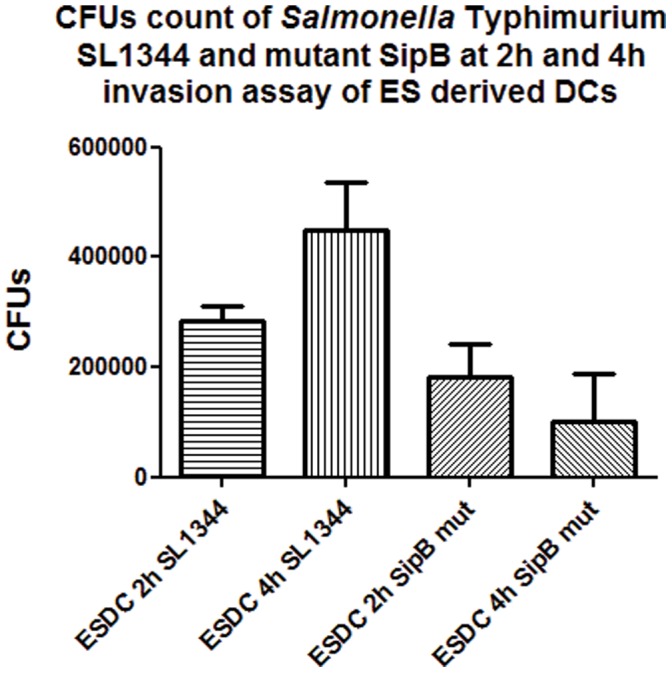
Gentamicin invasion assay.The ability of S. Typhimurium SL1344(p1C/1) to invade ESDCs was measured by the gentamicin assay described in Methods. ESDCs were exposed to either wild type S. Typhimurium or a SipB mutant for 30 minutes and then incubated with media containing 50 µg/ml of Gentamicin for 2 or 4 hours and then invading bacteria were enumerated.